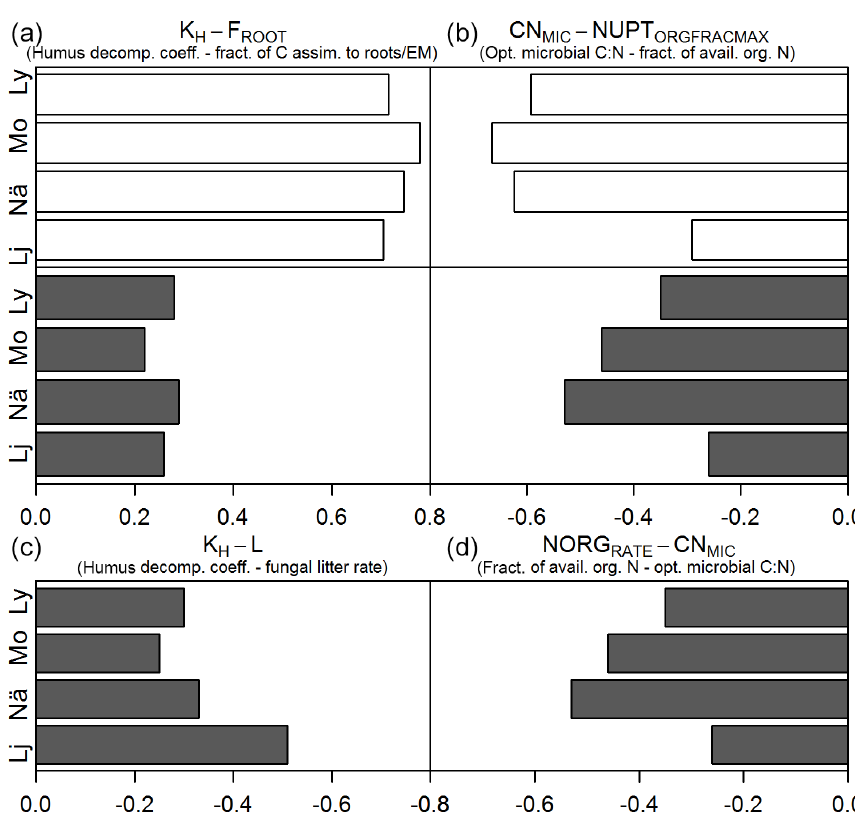
Figure 9. Correlation between model parameters, given as the Pearson correlation coefficient, for the implicit (white) and explicit ECM (black) approaches. (a) Correlation between humus decomposition coefficient ( K H ) and the fraction of C assimilates (GPP) directed to ECM and roots ( F ROOT ) . (b) C / N of microbes (CN MIC ) and fraction of organic N available for uptake (NUPT ORGFRACMAX ) . Correlation between ECM fungal parameters includes (c) humus decomposition coefficient ( K H ) and ECM fungal litter rate ( L ). (d) ECM organic N uptake (NORG RATE ) and C / N of microbes (CN MIC )